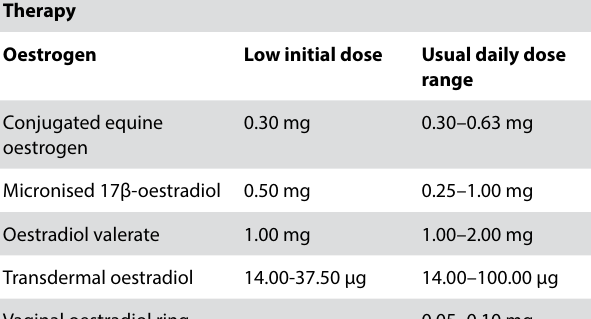
Key points on menopausal hormone therapy